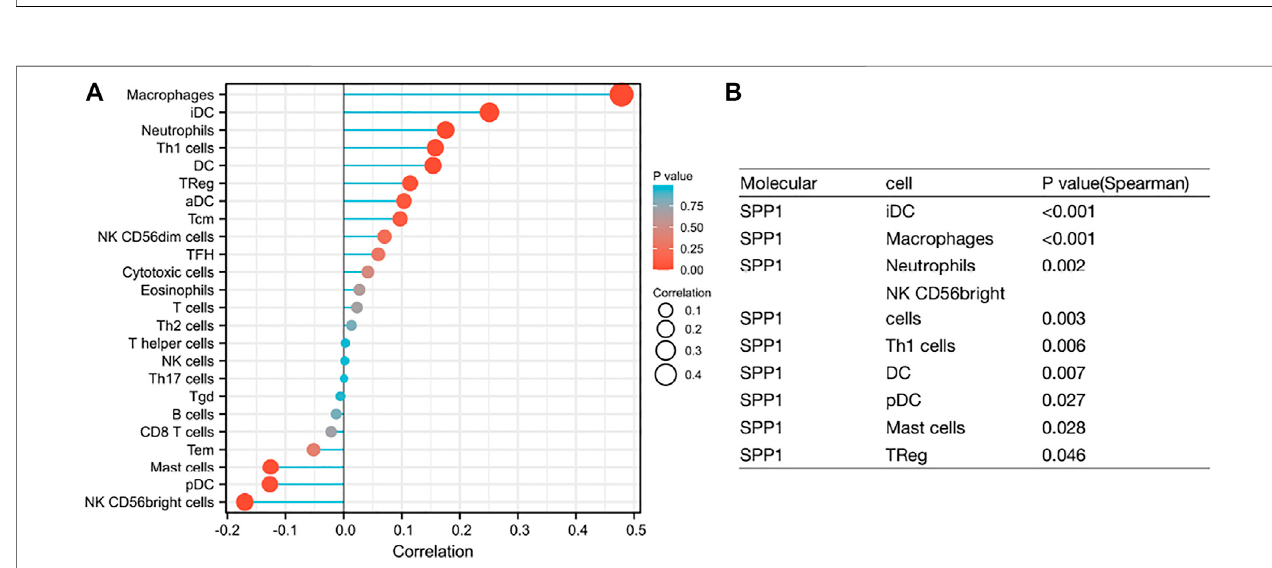
FIGURE 5 | Function and pathway enrichment analysis of SPP1 in cervical cancer. (A) Signi fi cant Gene Ontology terms (including BP, MF, and CC) of the top 100 genes most positively associated with SPP1 . (B) Signi fi cant KEGG pathway of the top 100 genes most positively associated with SPP1 .